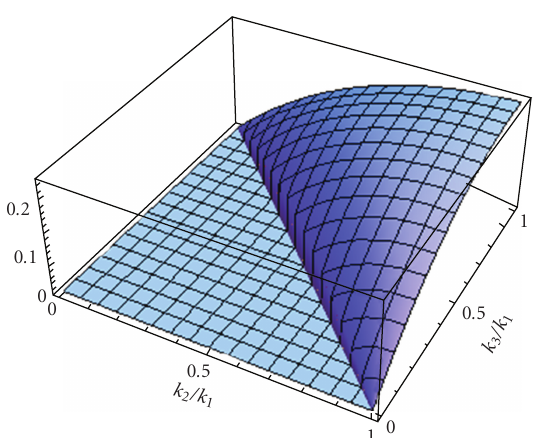
Figure 3: Shape of S λ in (121).